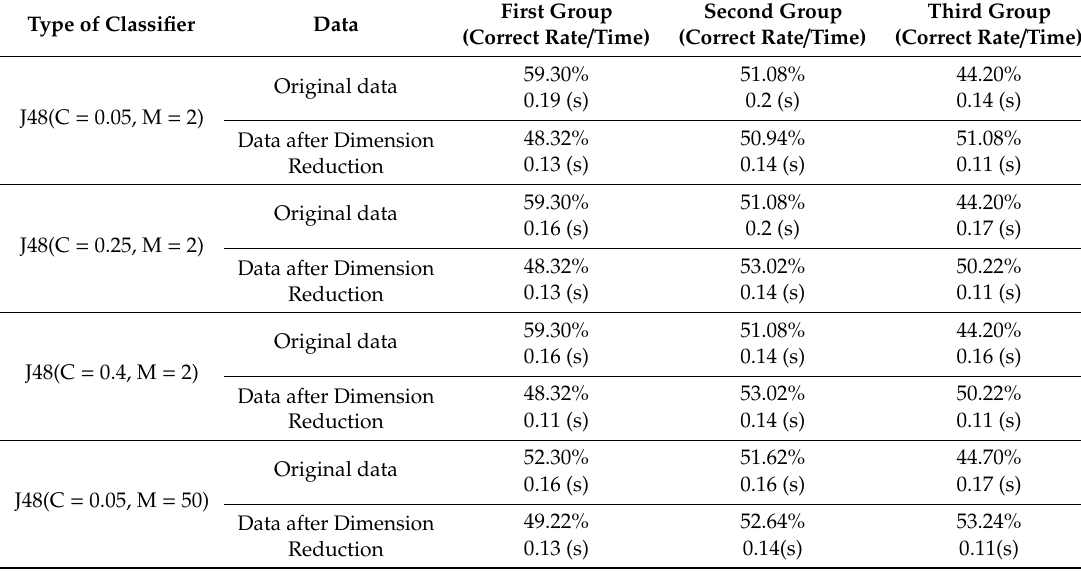
Table 4. J48 training and detection